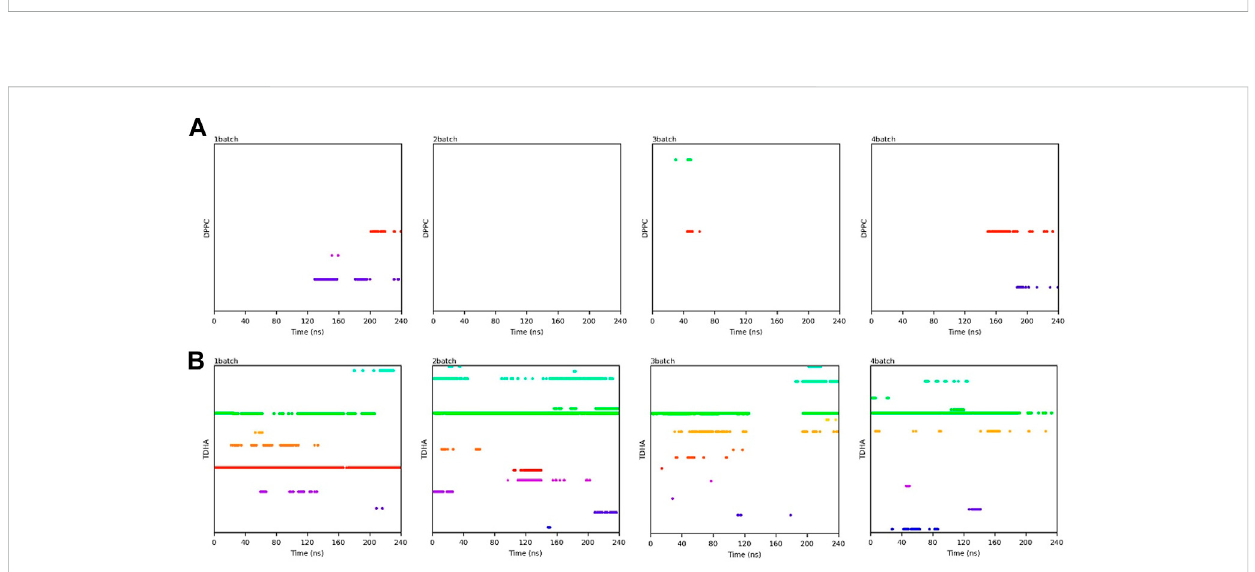
FIGURE 11 Binding time of thesubstrates (A) PC; (B) DHA-TAG inthe active center of PLA1 insolvent-free system with micro-water. Each color represents one substrate molecule. The length of the line with each color re fl ected the stability of the relevant complex; DPPC stands for PC and TDHA stands for DHA- TAG in the fi gure